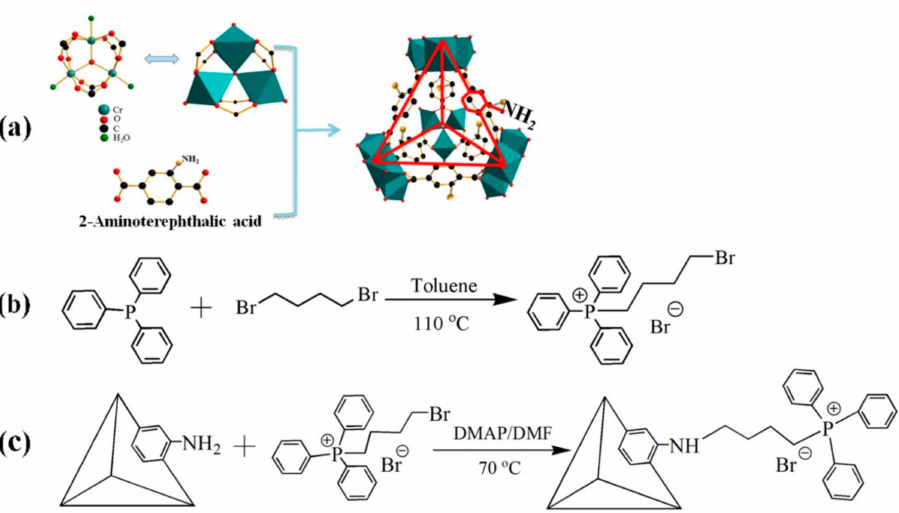
Figure 11. Preparation stages and model structure of Cr-MIL-101-[BuPh 3 P]Br. ( a ) Synthesis and activation of Cr-MIL-101-NH2, ( b ) Synthesis of (4-bromobutyl)triphenylphosphonium bromide, ( c ) Synthesis of [BuPh3P]Br-functionalized Cr-MIL-101. Reprinted with permission from Ref. [157].